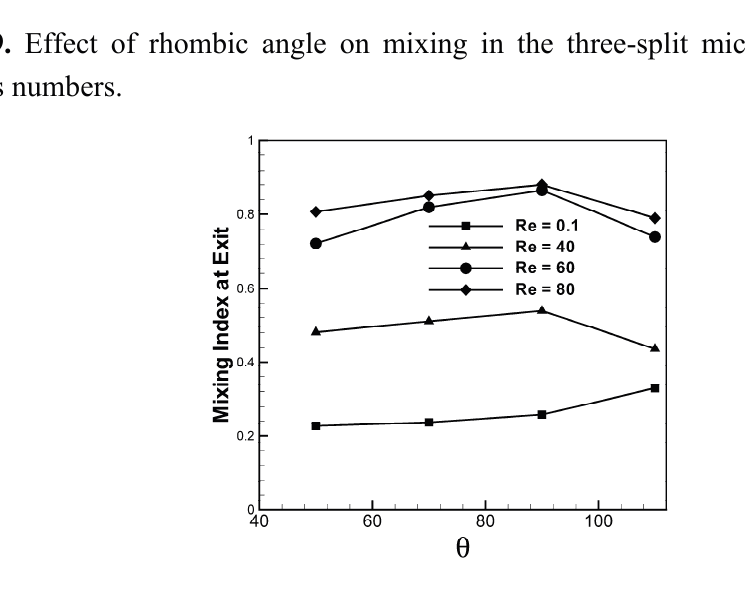
Figure 10. Velocity vector plots on y - z planes at Re = 50 in the three-split micromixer for various rhombic angles.